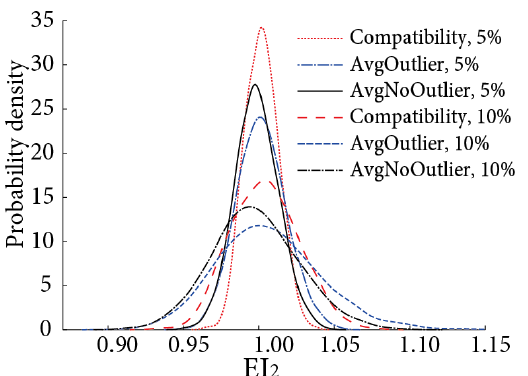
Figure 9. The probability density curve of the estimations using strategies 2 (compatibility condi- tions), 3 (averaging) and 4 (averaging with outliers ruled out).